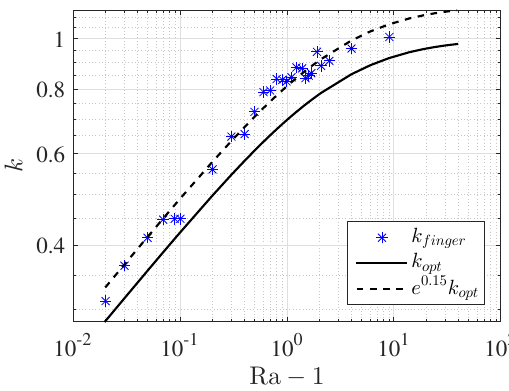
Figure 9. Horizontal finger scale vs. Ra. The quantity k finger denotes the dominant wavenumber in the time-averaged spectrum of the statistically steady state, while k opt denotes the optimal wavenumber.